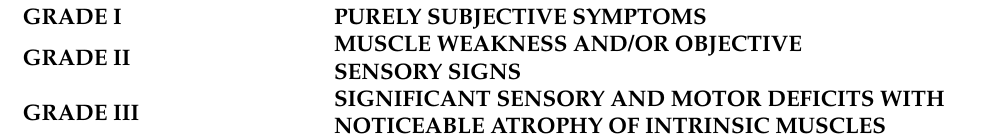
Table 1. The McGowan scale for the grading of cubital tunnel syndrome: grade I corresponds to a minimal lesion, grade II to an intermediate lesion, and grade III to a severe